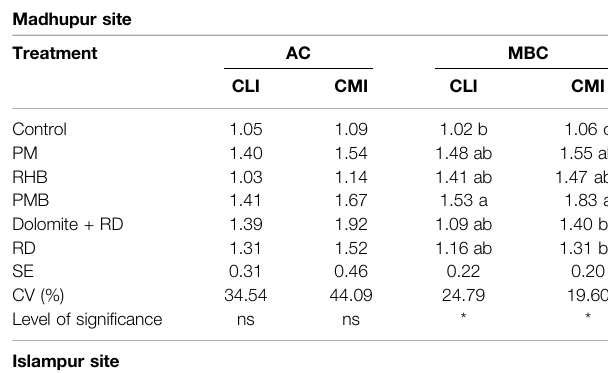
TABLE 4 | Effects of different treatments on carbon lability and management indices of active and microbial biomass at Madhupur and Islampur sites at a depth of 0 – 15